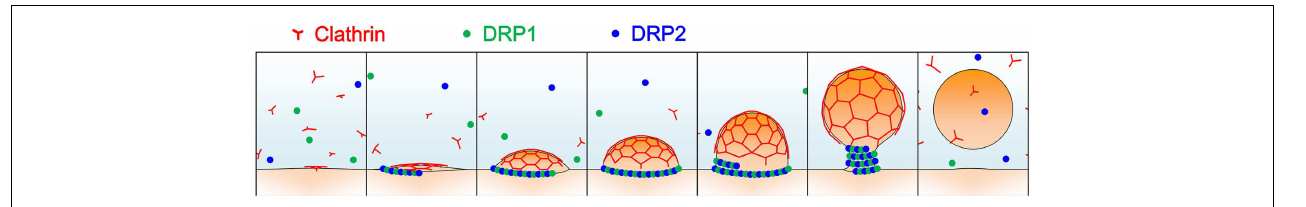
represent the donor membrane and the clathrin coat, respectively; and green and blue dots represent DRP1 and DRP2 proteins, respectively.